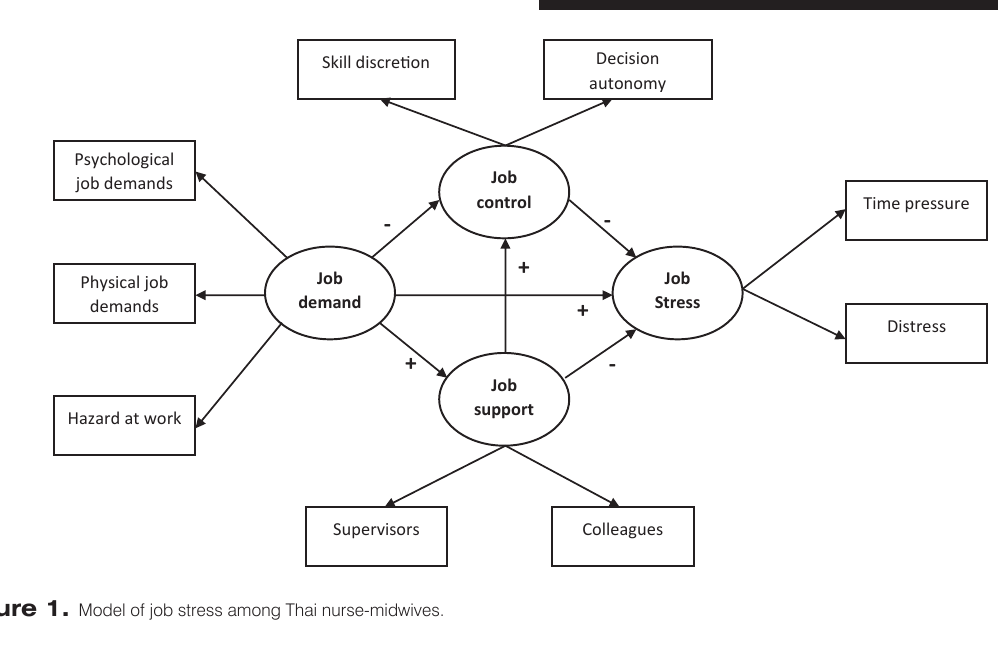
Figure 1. Model of job stress among Thai nurse-midwives.